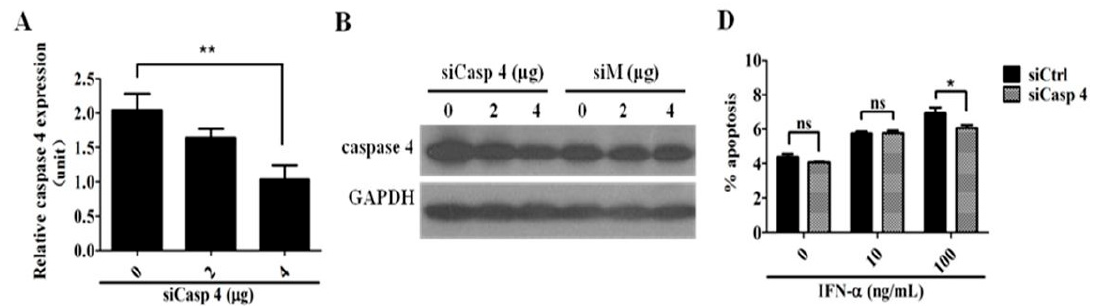
GAPDH (glyceraldehyde-3-phosphate